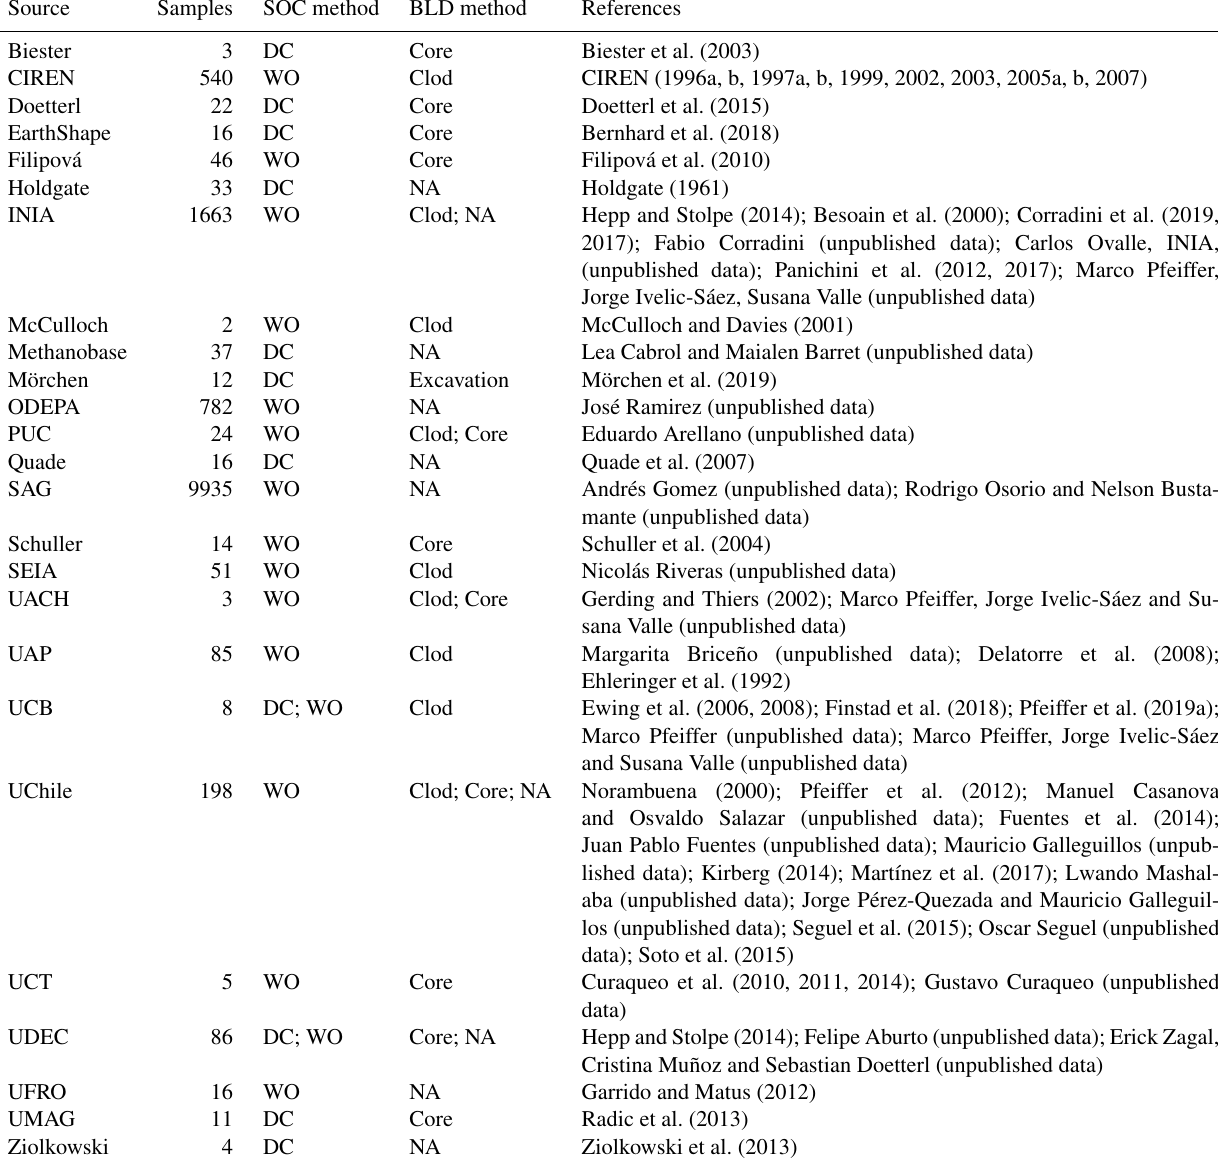
Table 1. Database sources used in this